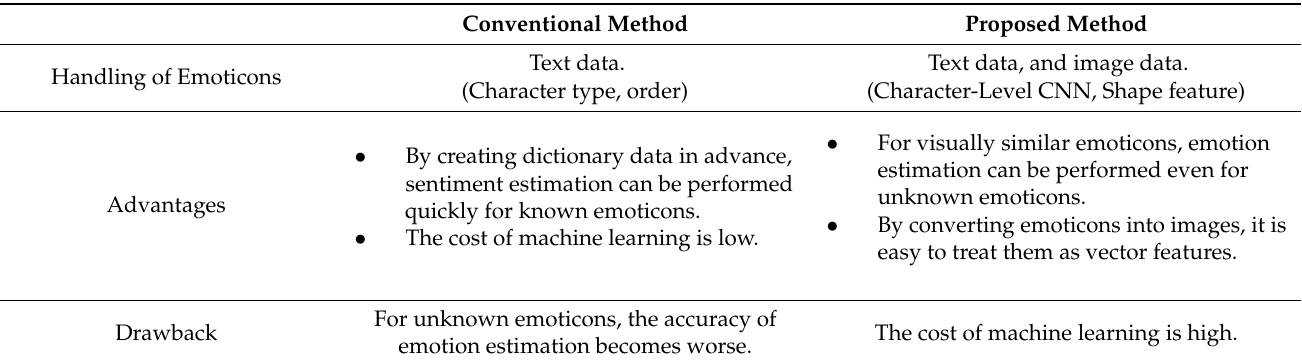
Table 2. Comparison of the proposed method with existing